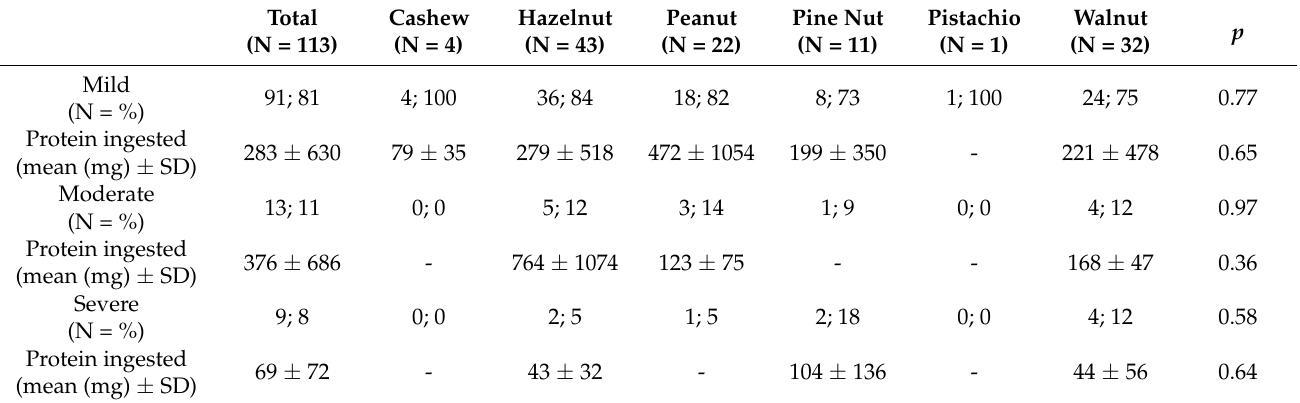
Table 6. Severity of reaction of the positive oral food challenge and dose of nut